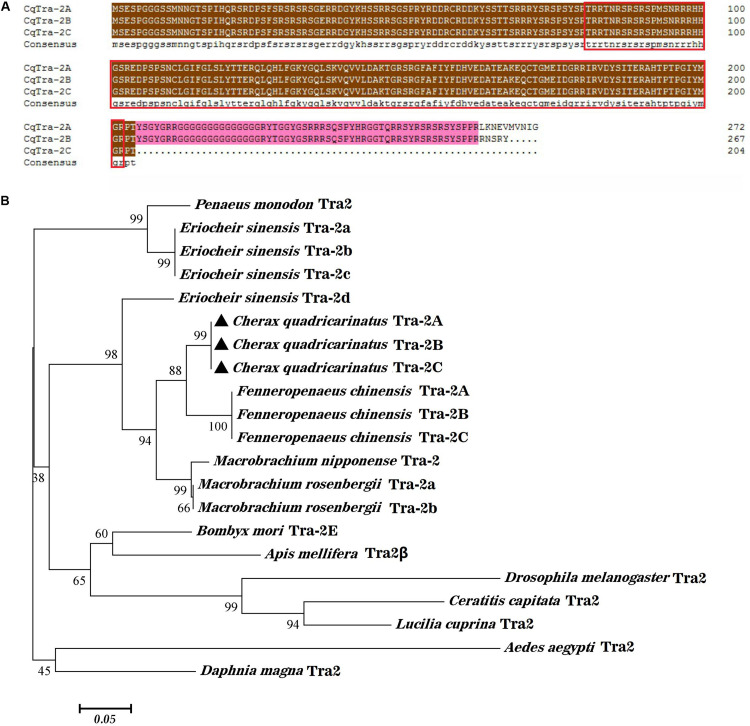
Amino acid alignment and phylogenetic tree analysis of Tra-2. (A) Sequence alignment of three isoforms of Tra-2 in C. quadricarinatus. Red rectangle indicates the RRM domain. (B) Phylogenetic tree construction of Tra-2 protein (Neighbor-Joining method). The black triangle shows the C. quadricarinatus species, and numbers in the branches represent the bootstrap values (%) from 1000 replicates. Species names and Tra2 protein types are listed on the right of the tree.